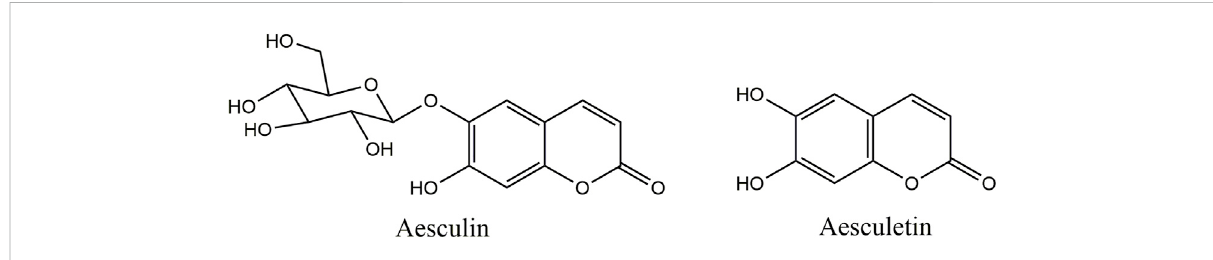
FIGURE 1 Molecular structures of aesculin and